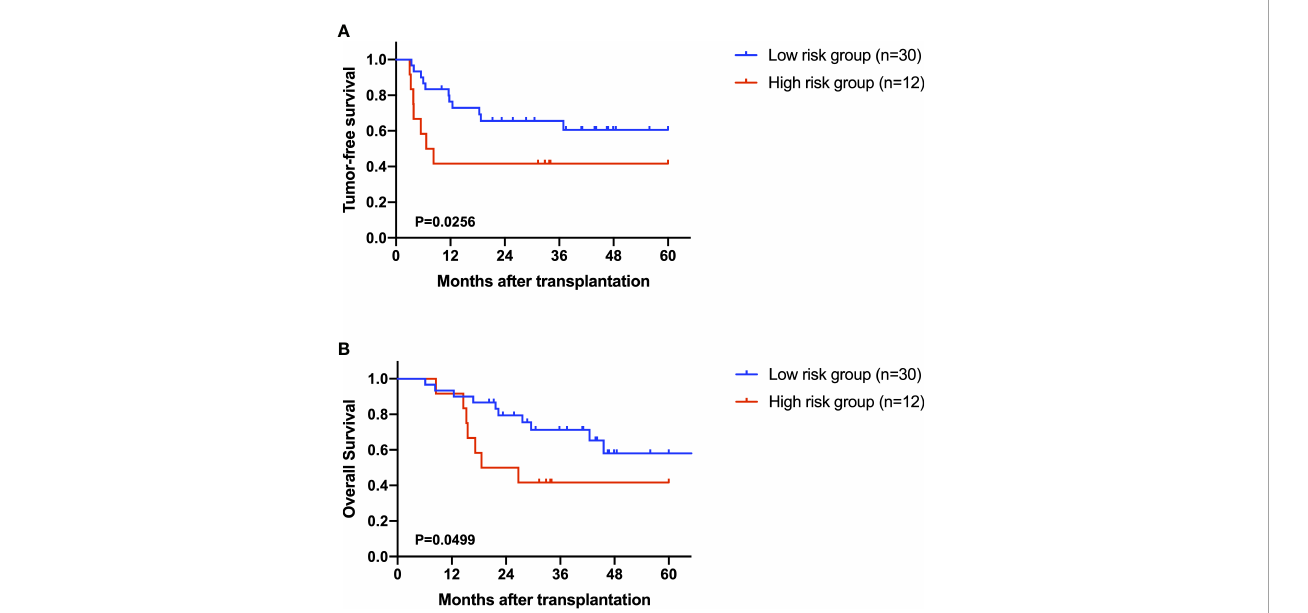
FIGURE 6 The role of MG(18:2/0:0/0:0) in the prediction of prognosis. (A) Kaplan-Miere plot of tumor-free survival in AFP negative HCC patients. (B) Kaplan-Miere plot of overall survival in AFP negative HCC